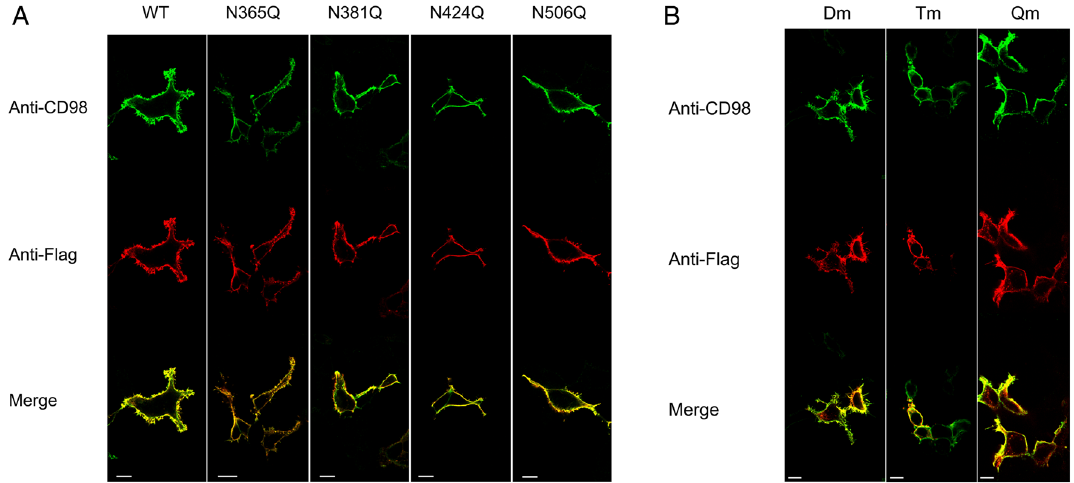
Figure 3. Cell distribution of WT and N-glycosylation mutants of CD98. Cells were transiently transfected with WT or mutant constructs. After 24 h, cells were fixed onto the slide and stained with anti-CD98 18 that recognizes the epitope protruding towards the extracellular side. After extensive washing the samples were permeabilized using Triton X100 and stained with the anti-FLAG that recognizes the tag located at the N-terminus 33 . Samples were then analyzed by confocal microscopy. Confocal images showed a single, representative, section of a Z-series taken through the entire cell. WT and single mutants were shown in panel ( A ), while double (Dm: N381/424Q), triple (Tm: N365/381/424Q), and quadruple (Qm: N365/381/424/506Q) mutants were shown in panel ( B ). Scale bar 10 µm.